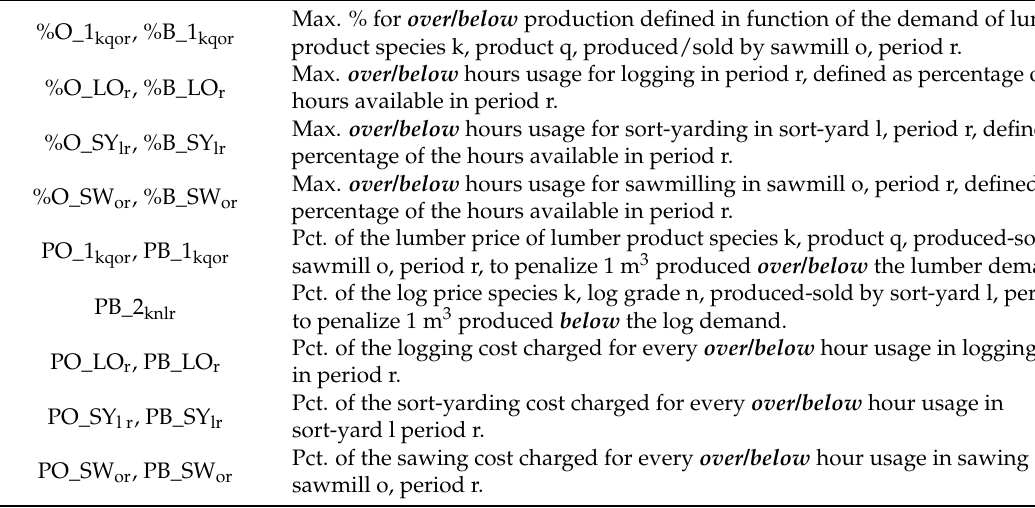
Table A4. Allowable quantities to penalize lumber production, capacity usage, and economic